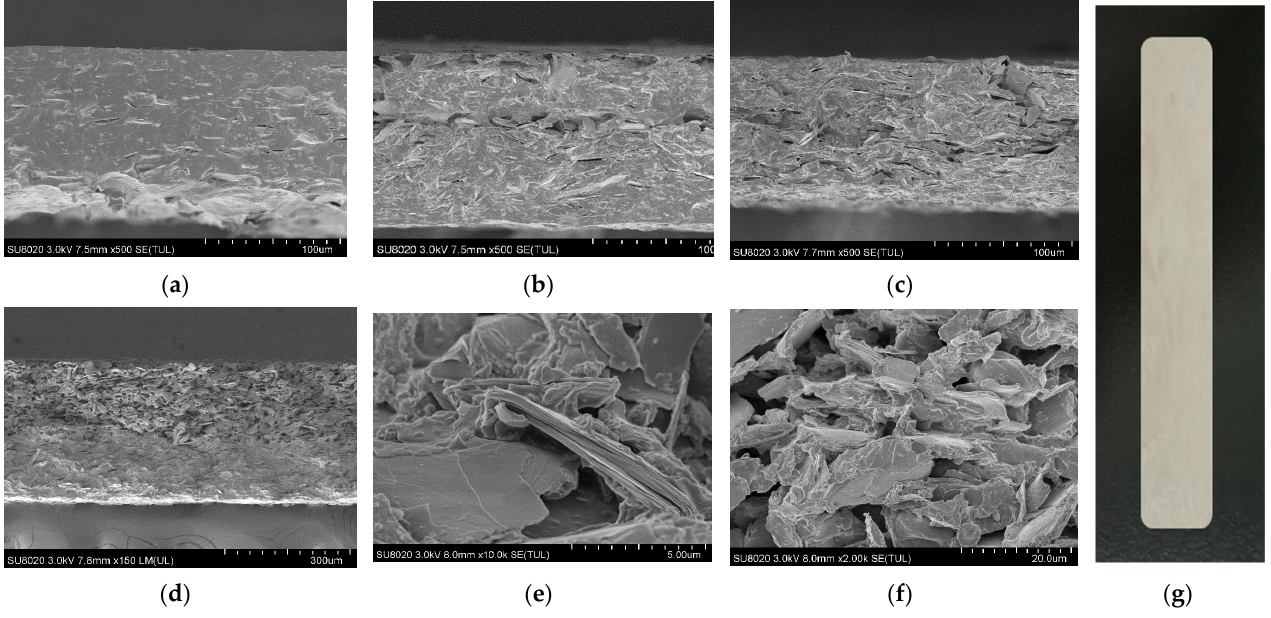
Figure 1. Cross-sectional images of the mica/chitosan composites with different mica mass fraction: ( a ) 20 wt%; ( b ) 40% wt; ( c ) 50% wt; ( d ) 70% wt. Cross-section images of the mica/chitosan/nanocel- lulose composites with different nanocellulose contents: ( e ) 5 wt%; ( f ) 15 wt%, the mass fraction of mica is controlled to be 50 wt%. ( g ) The samples of mica/chitosan composites.